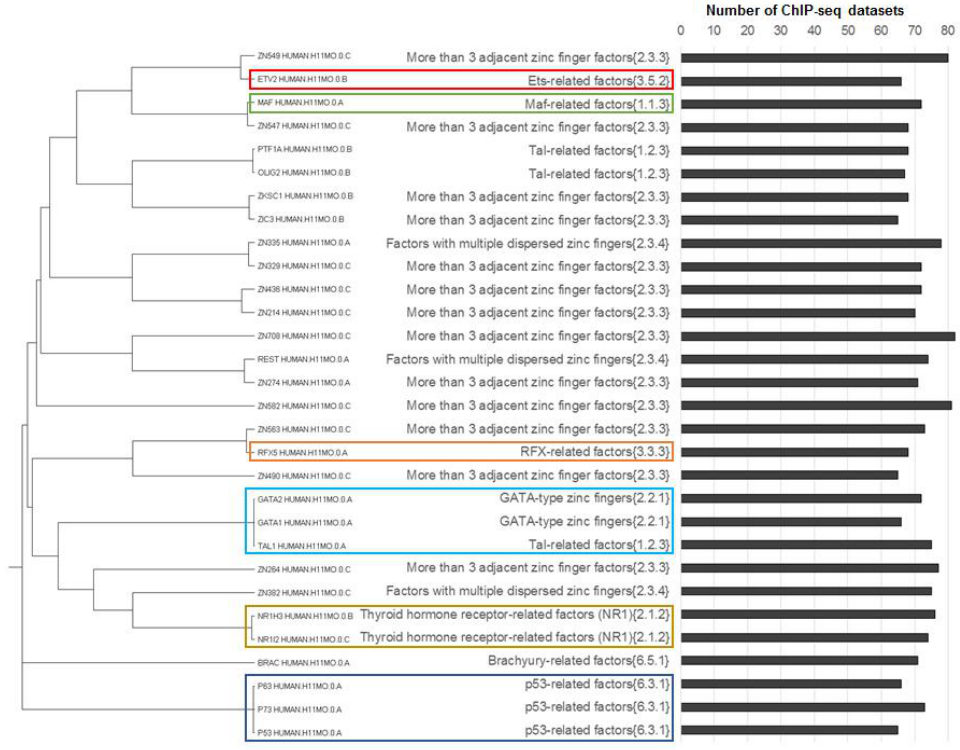
Figure 6. Clustering of 30 top-ranked partner motifs from the Hocomoco human core collection [14], according to their abundance in CEs predicted with an overlap of anchor motifs. We excluded from the analysis CEs containing the significant homology between motifs. The left/middle/right columns show the tree constructed according to motifs homology, names of TF families [13] and the distribution of the number of ChIP-seq datasets that contained respective CEs. Brown, green, red, orange, blue and aqua boxes mark NR1H3-like motifs from thyroid hormone receptor-related factors (NR1) {2.1.2} family, Jun-like (Maf-related factors {1.1.3}), ETS-like (ETS-related factors {3.5.2}), RFX-like (RFX-related factors {3.3.3}, p53-like (p53-related factors {6.3.1}) and GATA-like (Tal-related factors {1.2.3}) motifs, respectively. Totally, we included in the analysis 119 ChIP-seq datasets for human TFs (Table